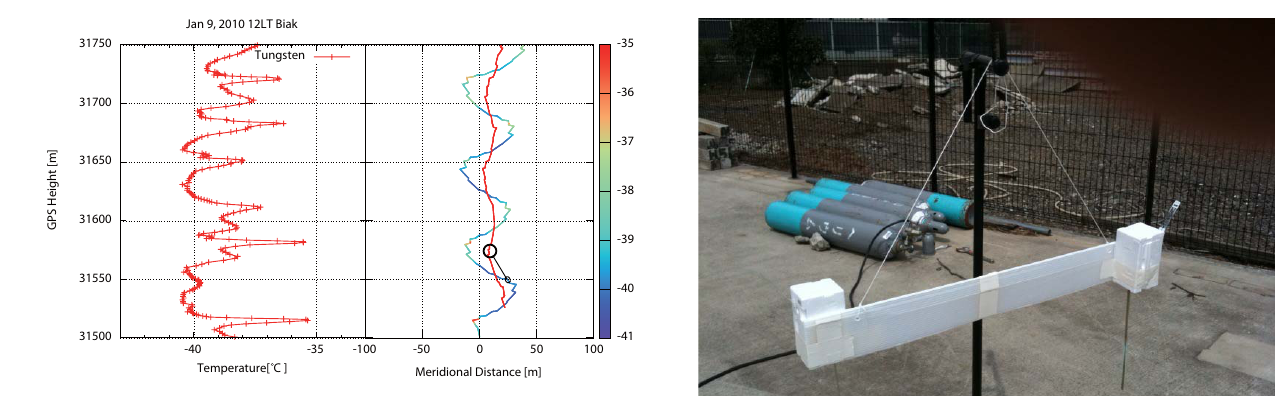
Fig. 4. Detailed temperature profiles from tungsten sonde (left) and the meridional projection of the trajectories for balloon (red) and sonde (color-coded by the temperature) estimated by GPS (right) taken from the daytime sounding at Biak, Indonesia on 9 Jan- uary 2010. The illustration on the right hand panel is the symbolic view of the flight configuration; the circle with the diameter of about 10m at the altitude of 31575m is the balloon, while the small cir- cle at 31550m is the radiosonde swinging under the balloon. Large heat pulses correspond to the sonde’s turn associated with the swing motion along the ascent. The sensor output has been low-pass fil- tered with the cut off at 3Hz before the data transmission to the ground station at 6Hz. The resultant vertical resolution is about 2m. 1200-gr balloon and 30-m suspension line are used.